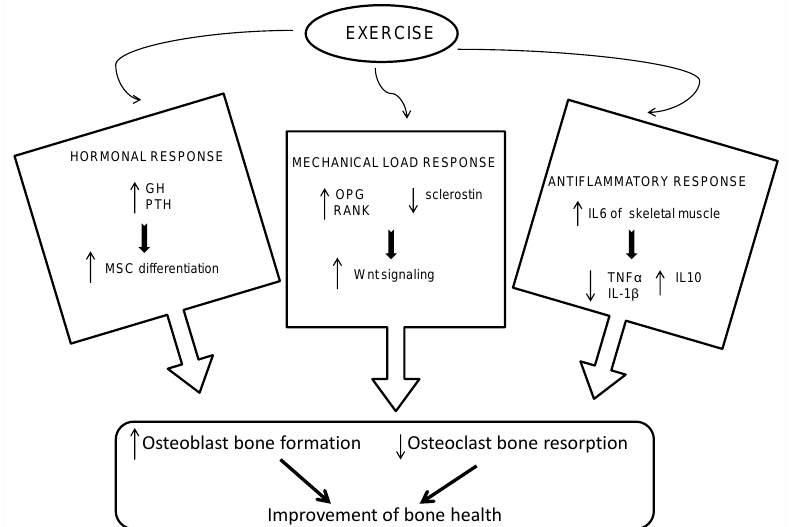
Figure 1. Physical exercise affects bone metabolism through various molecular and cellular pathways: stimulating the expression of some hormones; triggering the Wnt signaling pathway; activating the anti-inflammatory response. (GH: grow hormone; IL: interluchine; MSC: mesenchymal stem cell; OPG: osteoprotegerin; PTH: parathyroid hormone; RANK: receptor activator of nuclear factor Kappa-B; TNF- α : tumor necrosis factor- α).